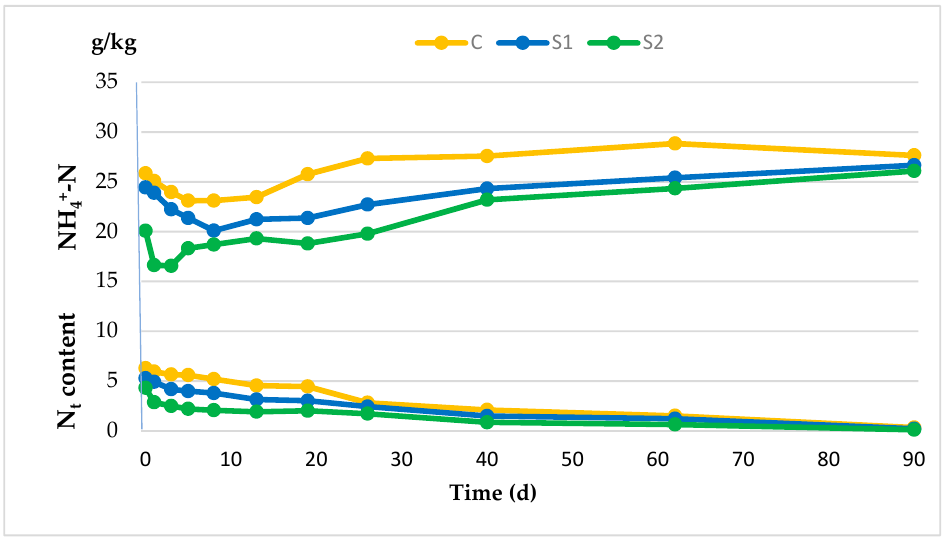
+ -N and N t content during 4